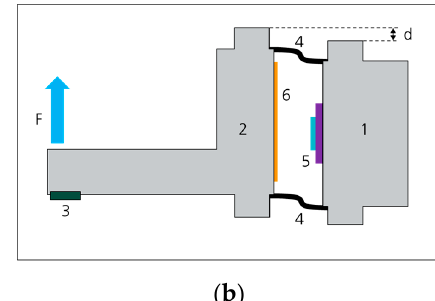
Figure 4. CAD models of the developed roller burnishing tool. ( a ): Side view of the complete tool with active front part (1), middle part with flexural sheet metals (2) and back-part with VDI tool-mounting unit (3). ( b ): Schematic drawing of the tool with functional parts: 1—Backside of the tool, 2—Frontside of the tool, 3—Roll used for the burnishing operation, 4—Flexural metal sheets, 5—Linear Encoder Head, and 6—Scale. The relative movement between the front and the back part (distance d) is measured by the scale to determine the processing force. Source: own-elaboration. The linear scale is a Renishaw Atom DX sensor with an interpolated resolution of 0.2